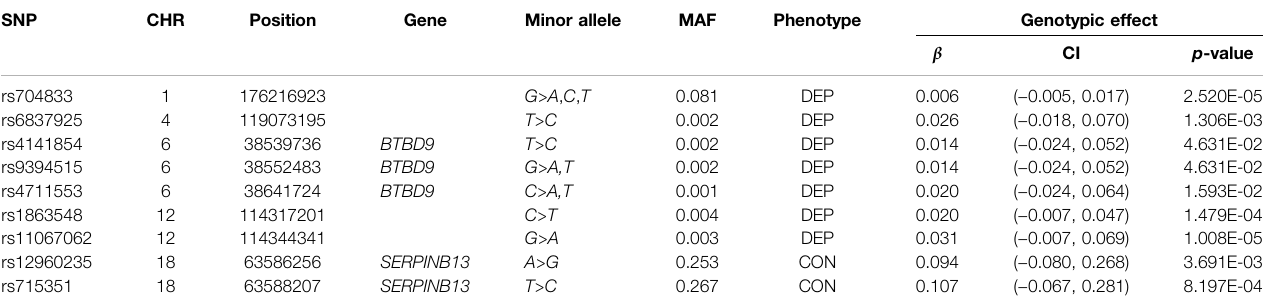
TABLE 5 | Genotypic effect test for fi ve